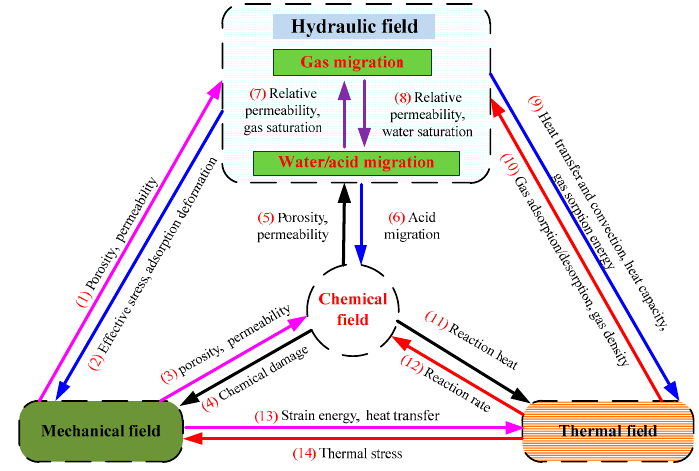
Figure 3. THMC coupling relation during acid fracturing enhanced CBM recovery.